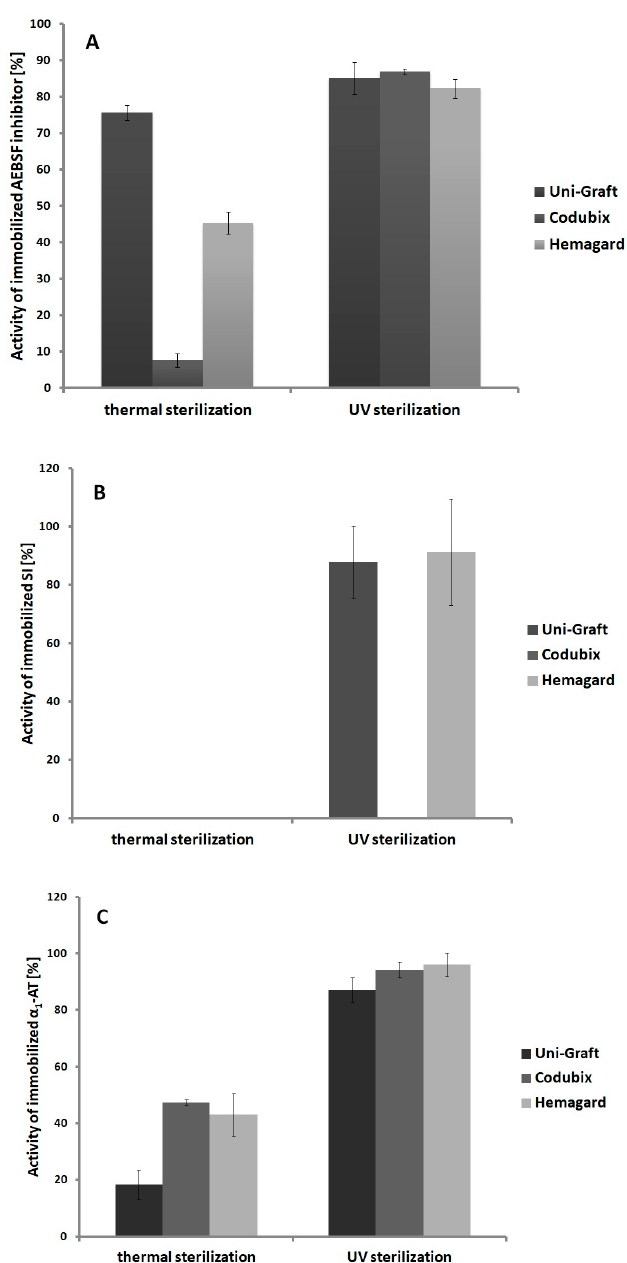
Figure 2. Influence of sterilization method on the activity of ( A ) AEBSF, ( B ) SI, and ( C ) α 1 -AT immobilized on various polymeric biomaterials.